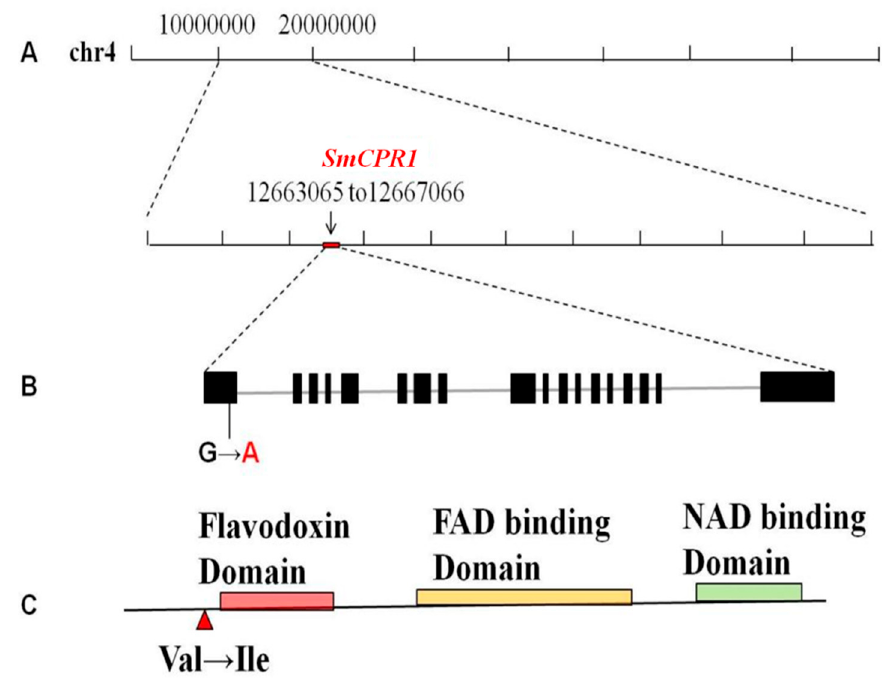
Figure 4. Location and structure of the candidate gene SmCPR1 and its amino acid sequence: ( A ) SmCPR1 is located on chromosome 4, and the red frame indicates SmCPR1 ; ( B ) structure and mutation site of SmCPR1 , black rectangles indicate exons and gray lines indicate introns, the mutation occurred in the first exon and the mutation base was from G to A; ( C ) the black line indicates the amino sequence, and the red, yellow, and green rectangles indicate the conserved domain database. FAD, flavin adenine dinucleotide. NAD, nicotinamide adenine dinucleotide.